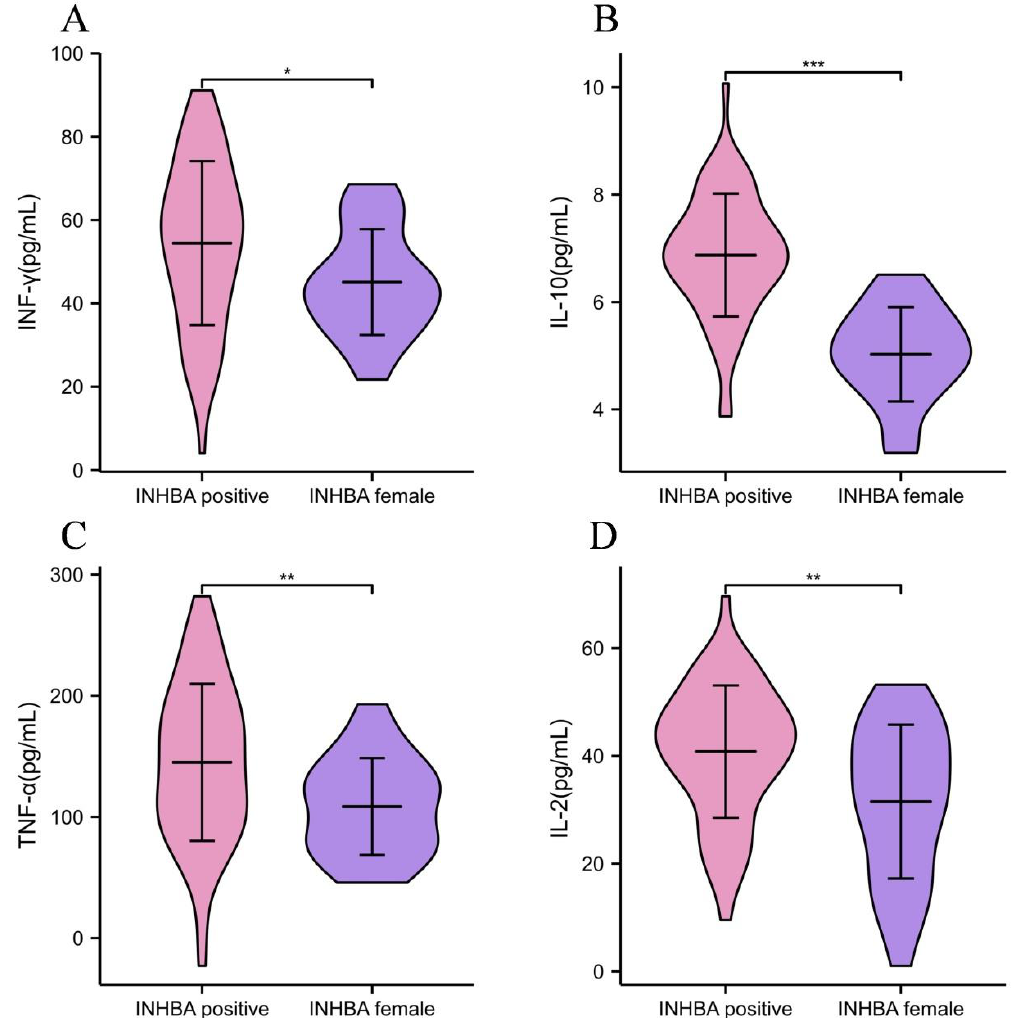
Figure 3. Comparison of anti-tumor immune response indexes in patients with different INHBA expressions. ( A ) IFN- γ content of patients with different INHBA expression; ( B ) IL-10 level in patients with different INHBA expression; ( C ) TNF- α content in patients with different INHBA expression; ( D ) IL-2 level in patients with different INHBA expression. * p < 0.05, ** p < 0.01 and *** p < 0.001.